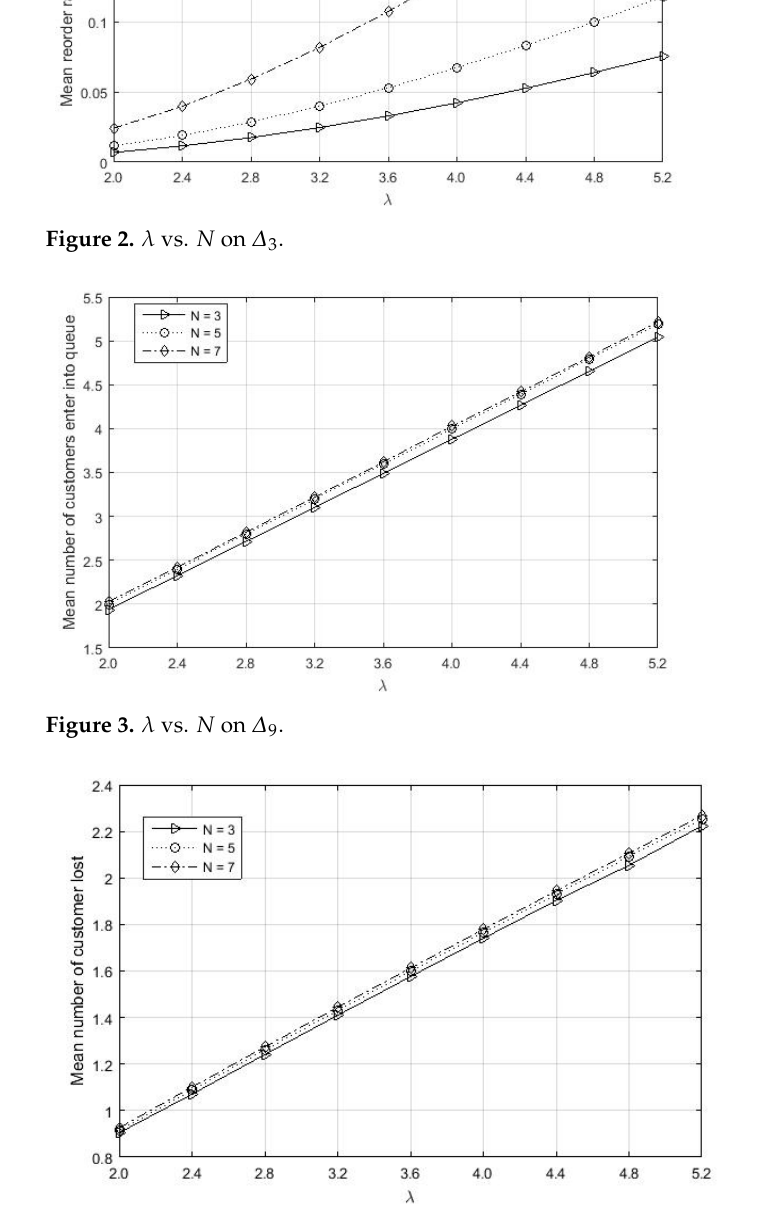
Figure 4. λ vs. N on ∆ 11